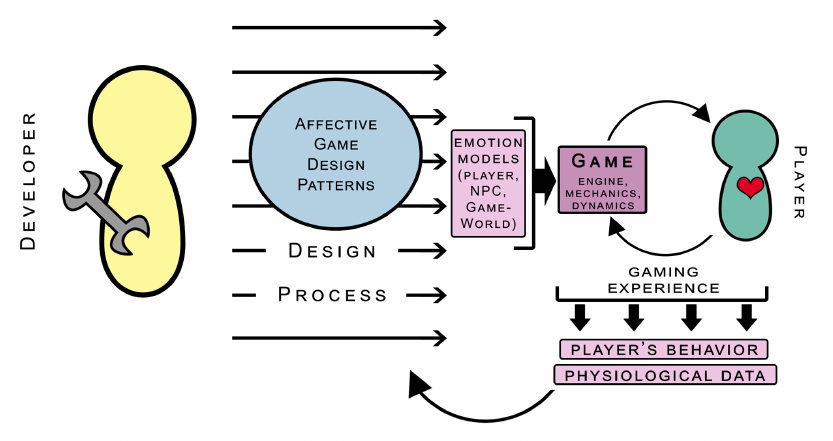
Figure 6. Affective game design patterns: Scheme of the concept.